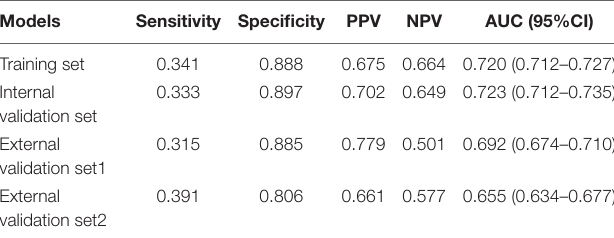
Frontiers in Cardiovascular Medicine |